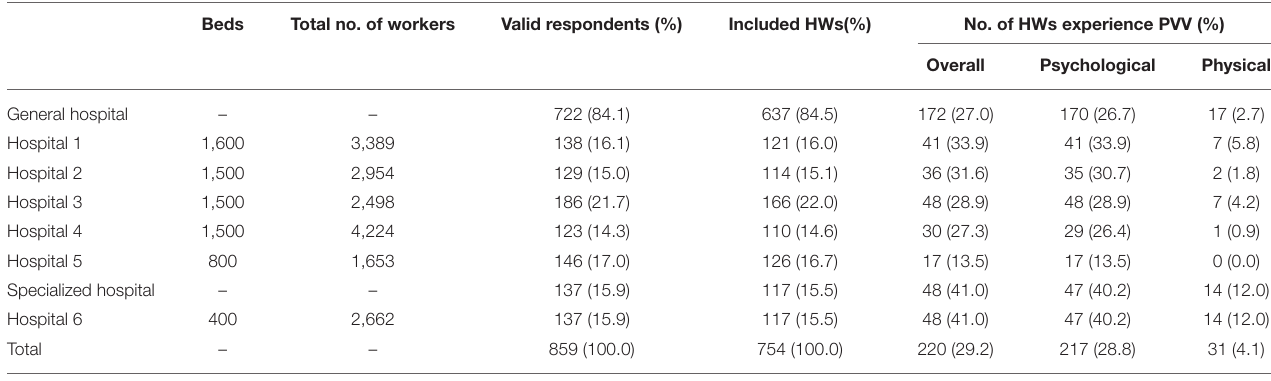
TABLE 1 | Description of hospital characteristics and the hospital-level prevalence of PVV.